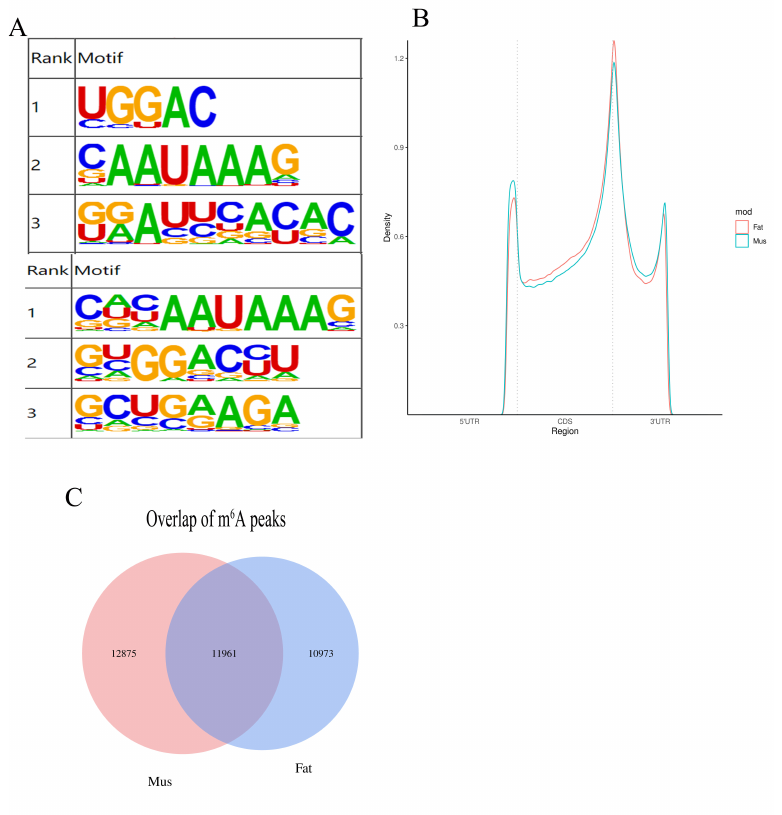
Figure 2. ( A ) Sequence logo showing the top motifs enriched across differential m 6 A peaks identified from muscle and fat samples; ( B ) distribution of m6A peaks across the length of mRNA; ( C ) overlap of m 6 A peaks from fat and muscle tissues. p ≤ 0.05 is statistically